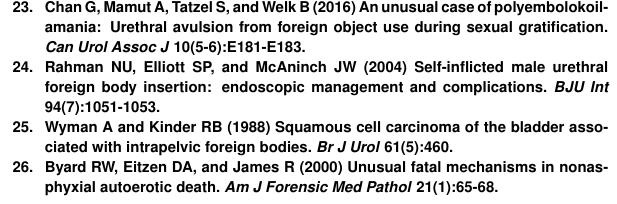
19. Bodenbach M, Bschleipfer T, Stoschek M, Beckert R, and Sparwasser C (2002) [Intravesical migration of a polypropylene mesh implant 3 years after laparo- scopic transperitoneal hernioplasty]. Urologe A 41(4):366-368. 20. Hutton KA and Huddart SN (1999) Percutaneous retrieval of an intravesical for- eign body using direct transurethral visualization: a technique applicable to small children. BJU Int 83(3):337-338. 21. NabiG,HemalAK,andKhaitanA(2001)Endoscopicmanagementofanunusual foreign body in the urinary bladder leading to intractable symptoms. Int Urol Nephrol